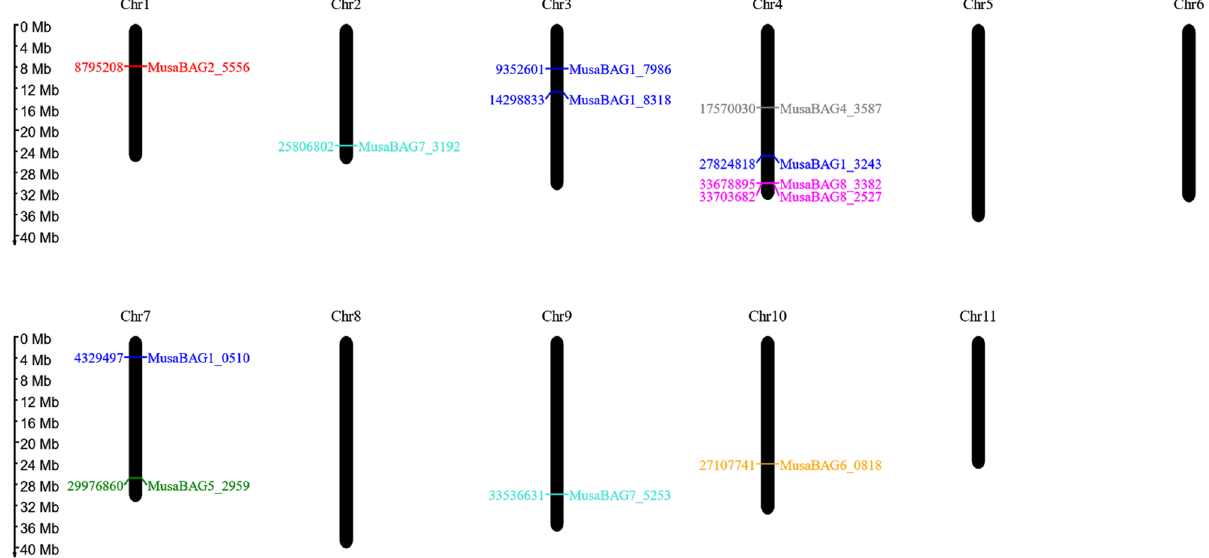
Figure 1. Chromosomal map showing the distribution of the MusaBAG gene family members on the A genome of banana ( Musa acuminata DH-Pahang AA type) using Map2GeneChrom v2.1 tool (http:// mg2c. iask. in).